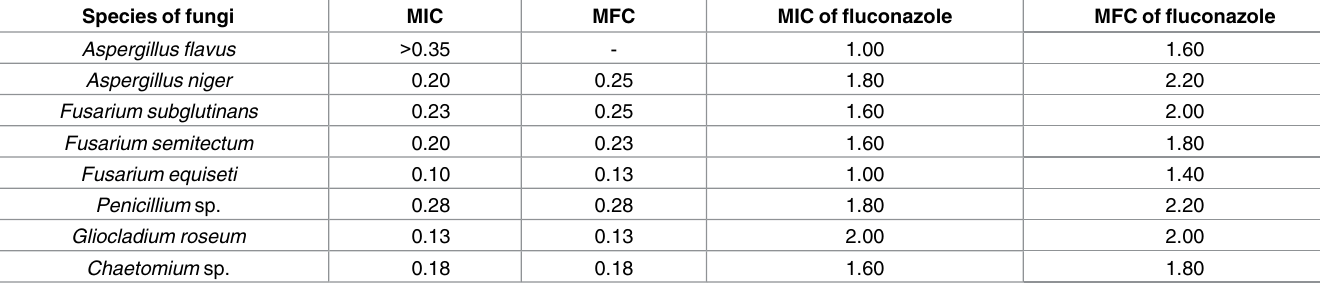
Table 3. Antifungal activities of defensive secretfrom Pachyiulus hungaricus (Karsch, 1881). Species of